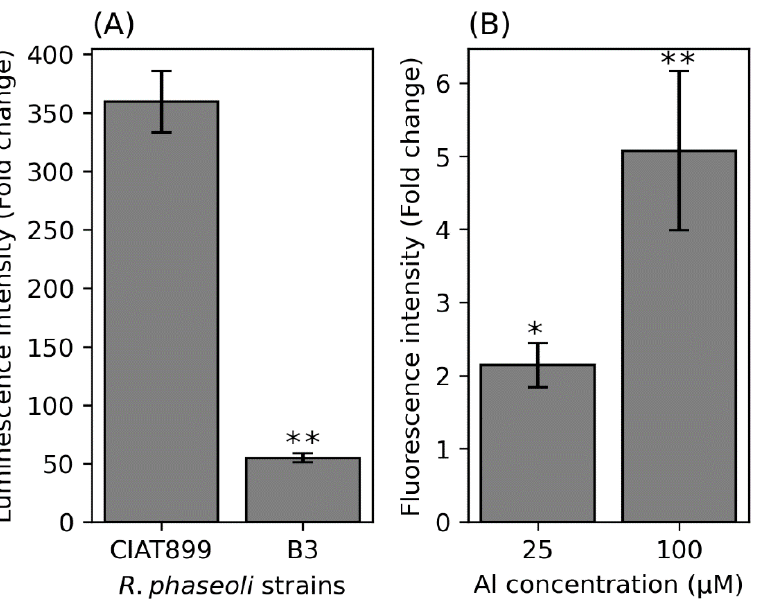
Figure 4. Extracellular ATP ( A ) and extracellular mScarlet-1 ( B ). Asterisks represent significance differences between luminescence intensity from CIAT899 and B3 ( A ) and fluorescence intensity between untreated B3 cells with Al-treated cells at various concentrations (one-way ANOVA; * p ≤ 0.05; ** p ≤ 0.001). Values on the y -axis show fold change compared to the untreated cells.